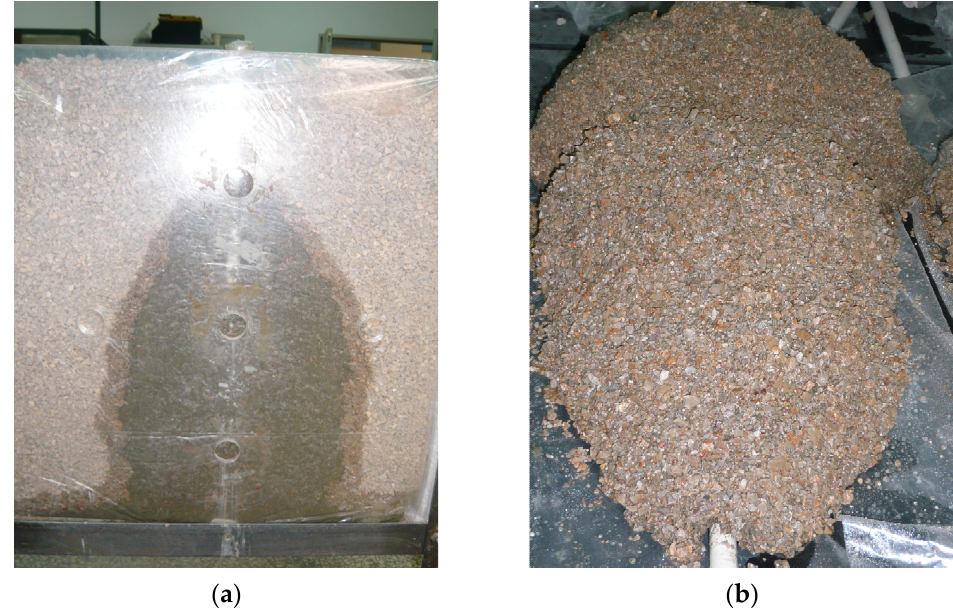
Figure 6. Photographs of grouting experimental process. ( a ) Permeation and diffusion form of Newtonian cement slurry in the gravel sand; ( b ) the grouted stone body.